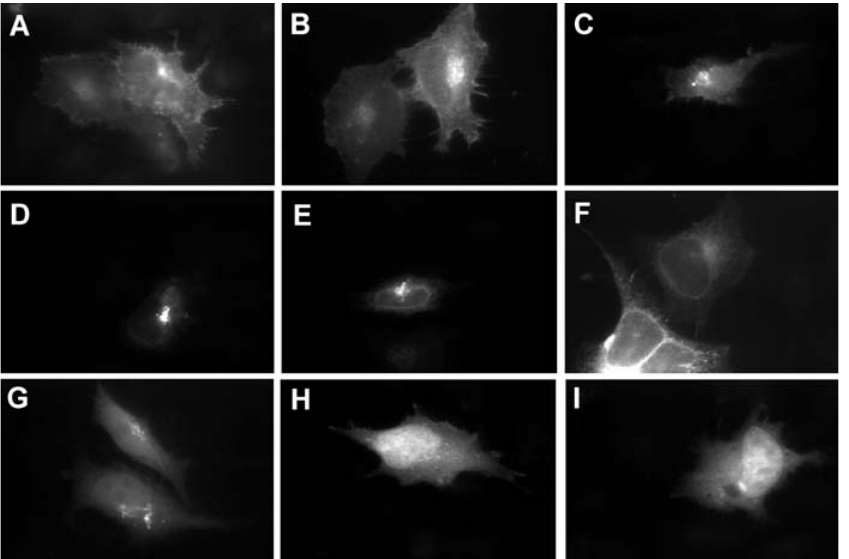
Figure 7. Observed Subcellular Localisations for Small SignalP Positive ORFs Predicted by CRITICA, Fused to GFP (A–C) Cell surface and peri-nuclear localisations of A430023G14, 1110065P19, and 5430416O09. (D and E) Nuclear envelope and peri-nuclear golgi-like localisations of E030042M04 and